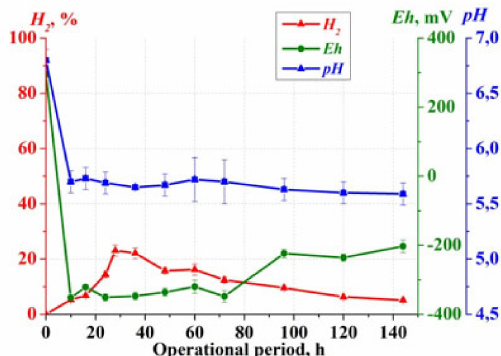
Figure 3. The inhibition of solid food wastes (SFW) fermentation in the absence of the granular microbial preparation and pH